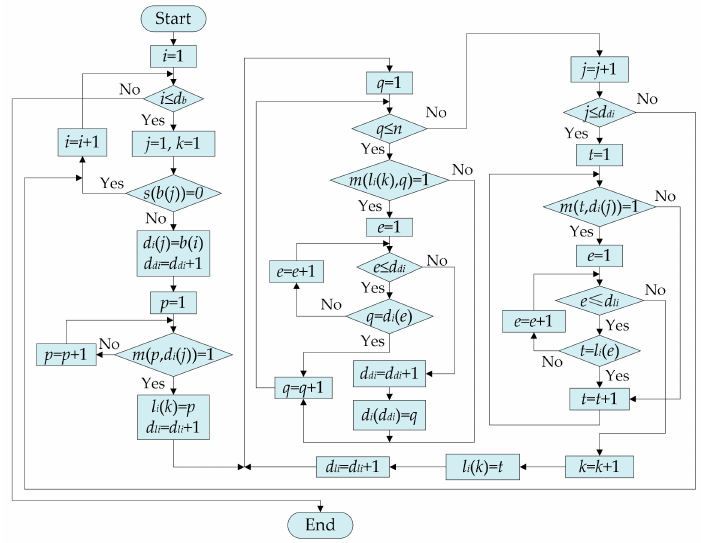
Figure 3. Algorithm to determine the MD sets and feeder section